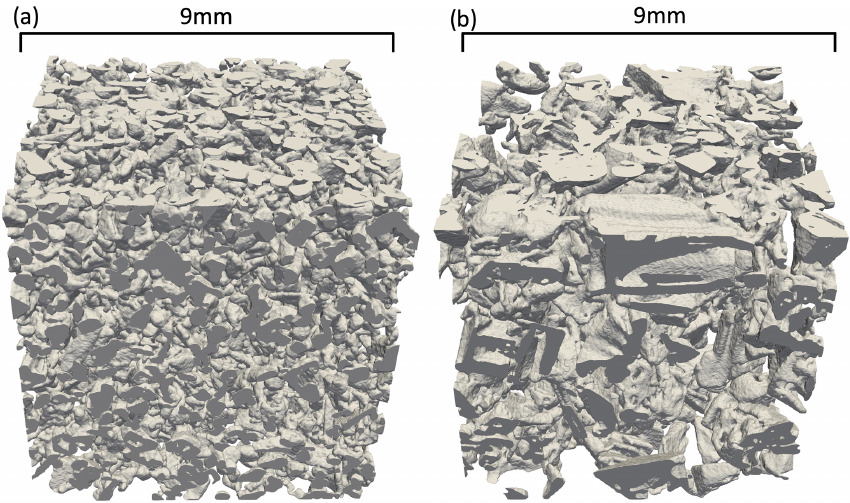
Figure 7. Three-dimensional renderings of mesh samples used to generate the optical properties for the general evaluation and snow trans- mittance comparisons. (a) Fine-grain sample and (b) coarse-grain sample.